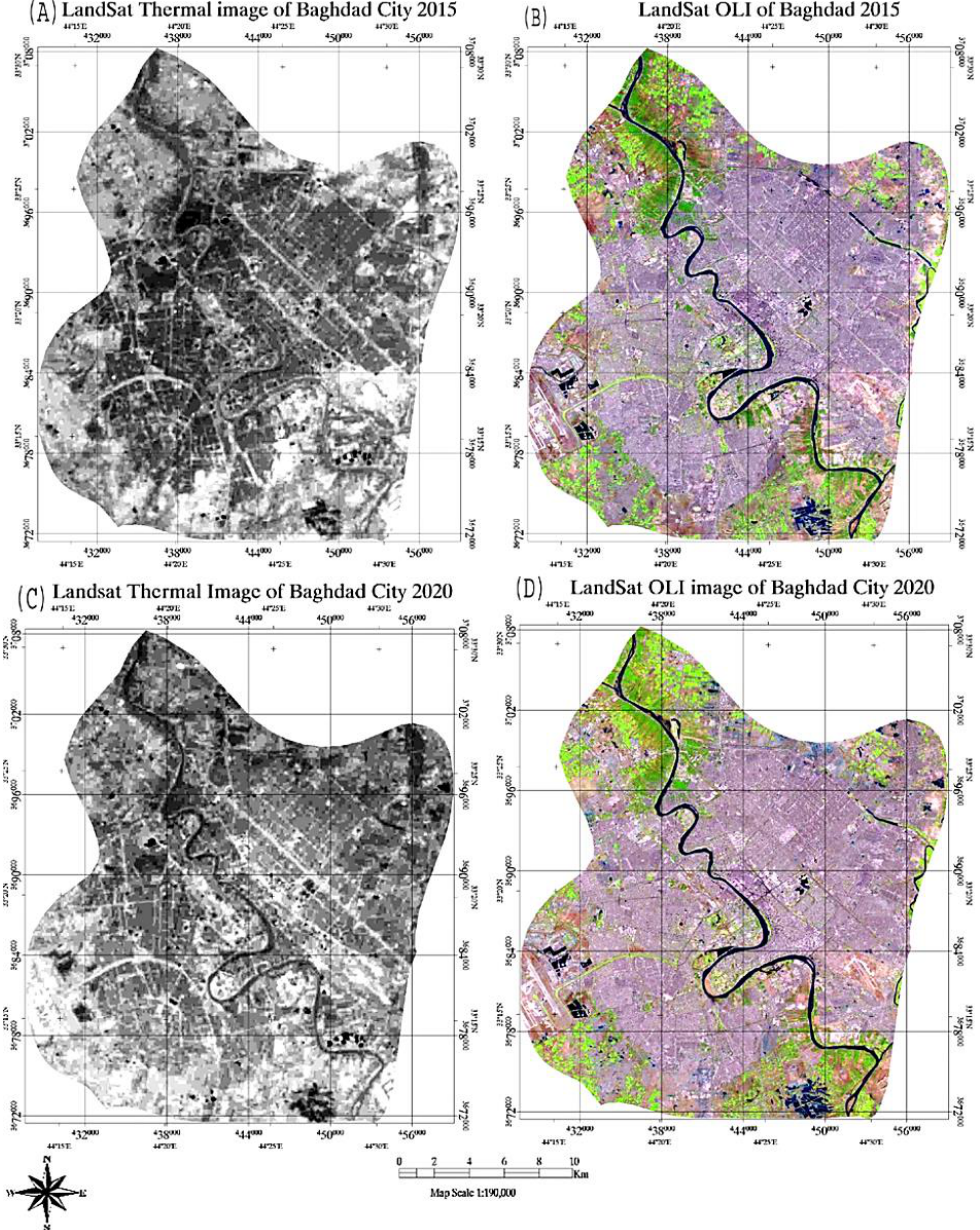
Figure 4. The subset of the satellite images are: (A) the corrected visible Landsat satellite image of the year 2015; (B) the corrected thermal Landsat satellite image of the year 2015; (C) the corrected visible Landsat satellite image of the year 2020; (D) the corrected thermal Landsat satellite image of the year